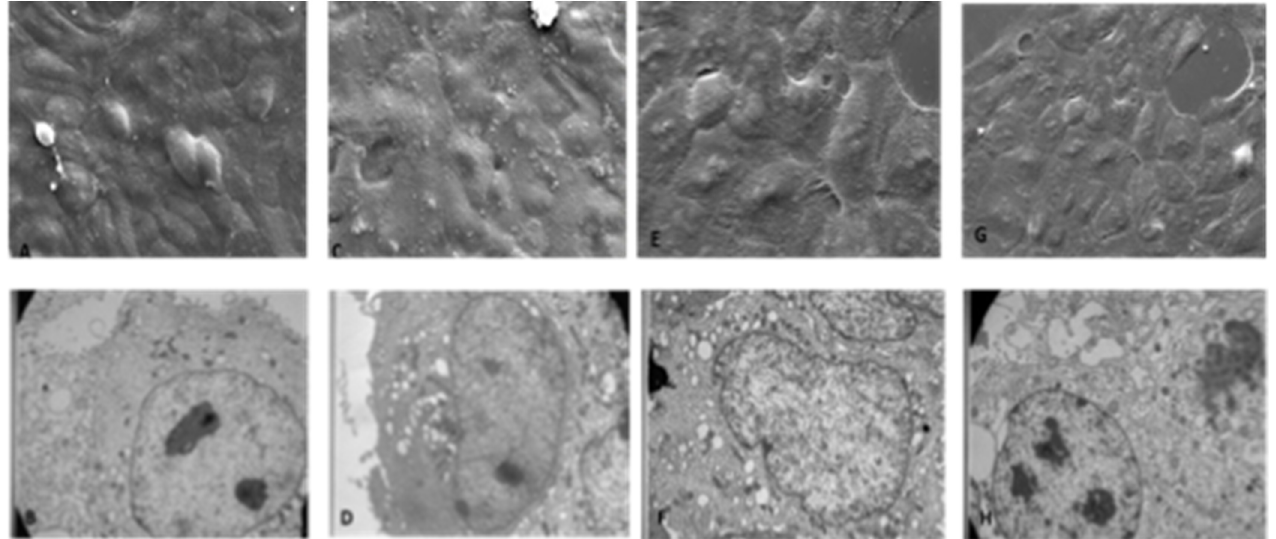
Figure 2. Effects of 100 ppm HOCl nebulization on HaCaT cells morphology analyzed by SEM and TEM microscopies. ( A ) Ctrl T0h; SEM image: morphologically normal cells, in tightly adhered uniform monolayer. ( B ) Ctrl T0h; TEM image: structurally unaltered nuclei and organelles, low percentage of vacuolated cells. ( C ) Ctrl T24h; SEM image: after 24 h the cellular carpet surface remains uniform without variations. ( D ) Ctrl T24h; TEM image: cells have normal cytoplasmic and nuclear structures. ( E ) 100 ppm T0h; SEM image: cells morphologically unchanged compared to controls, in monolayer it remains uniform. ( F ) 100 ppm T0h TEM image: the treatment at this concentration does not alter the cellular structure which remains the same as that observed in the controls. ( G ) 100 ppm T24h; SEM image: after 24 h the cellular carpet surface is still uniform. ( H ) 100ppm T24h; TEM image: cells have cytoplasmic and nuclear structure without relevant alterations. 5K magnification (SEM pictures) and 10K Magnification (TEM pictures).